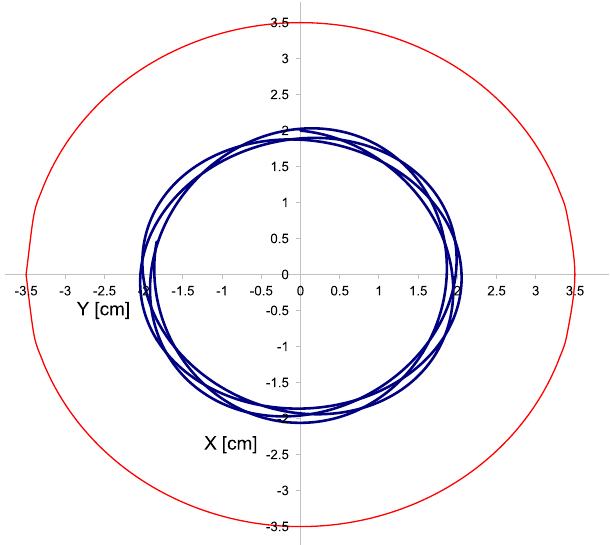
FIG. 4. Almost circular charged particle trajectory in presents of longitudinal